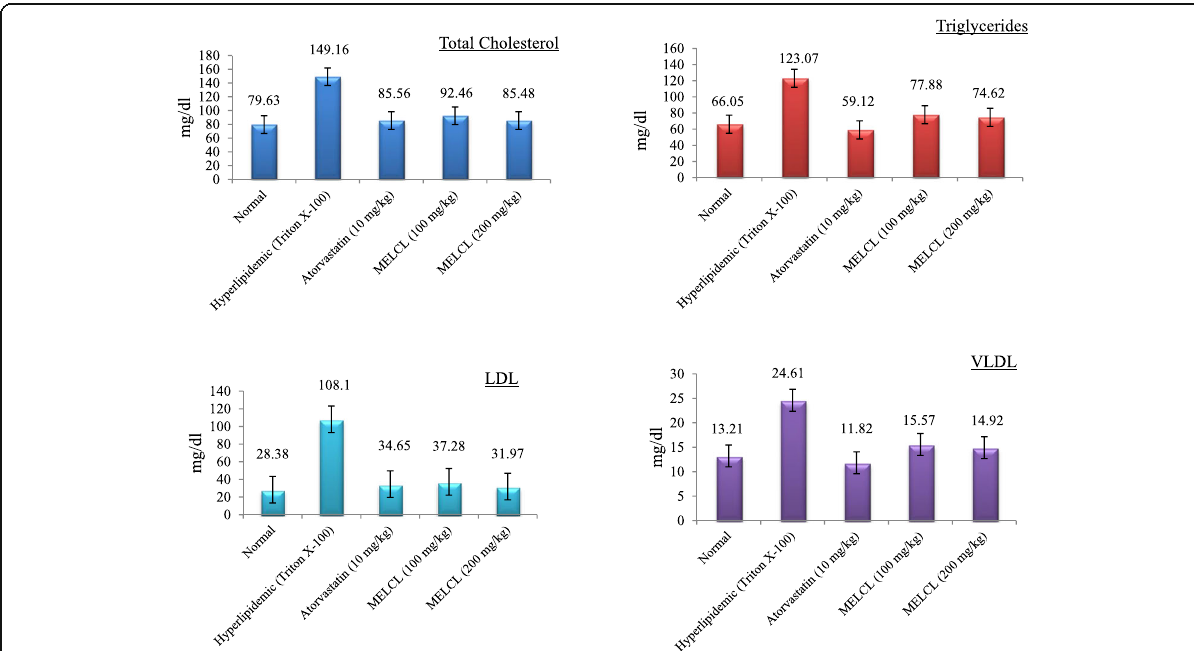
Fig. 1 Biochemical estimation of different groups for the level of Total Cholesterol (TC), Triglycerides (TG), Low Density Lipoprotein (LDL), Very Low Density Lipoprotein (VLDL). MELCL: Methanolic extract of Luffa cylindrica (L.)